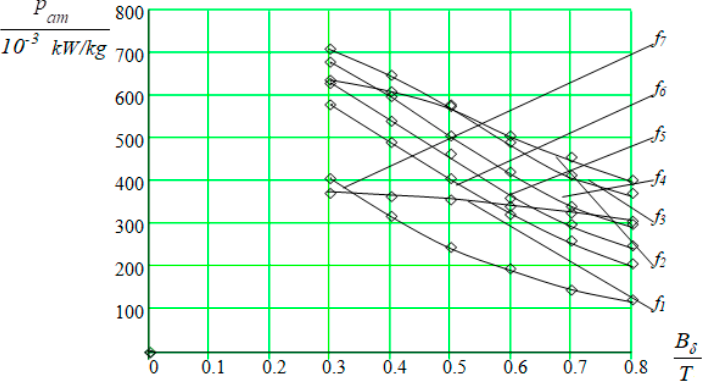
Figure 8. Dependence of the specific power p am on the value of induction in the air gap at a constant generator frequency: f 1 = 400 Hz; f 2 = 1000 Hz; f 3 = 2000 Hz; f 4 = 3000 Hz; f 5 = 4000 Hz; f 6 = 5000 Hz; f 7 = 10,000 Hz.